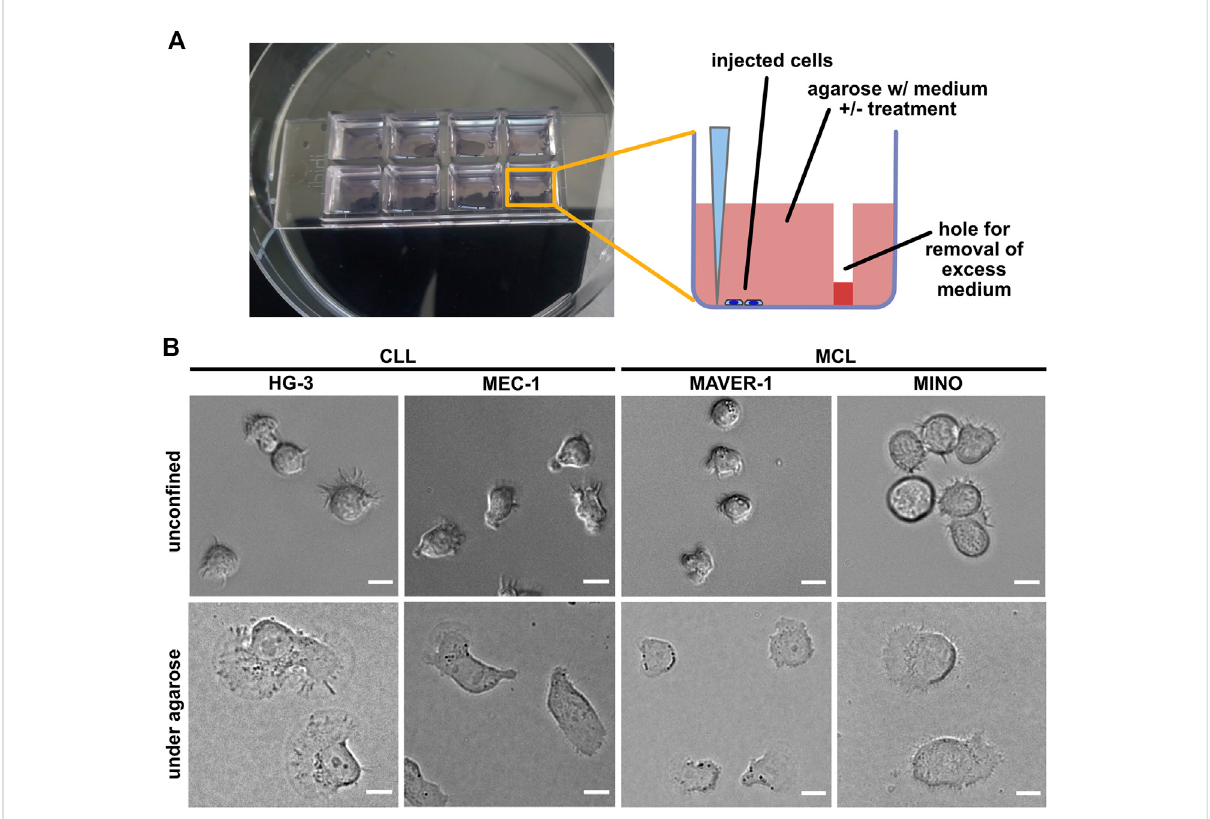
FIGURE 1 Experimentalsystemforanalysisofameboidmigrationofleukemiccelllines. (A) Schemeoftheunder-agaroseassayexperimentalsystemused for migration analysis. The cells are injected under the gel using a 10- μ l pipette at the side of the well opposite to hole punched in advance, which serves to collect excess medium. The collected medium needs to be removed before imaging to achieve ef fi cient con fi nement. Inhibitors or chemokines are added to the gelation mixture before the gel is poured into the wells. (B) Representative images of cell lines used in this study. Upper line: cell phenotypes in the normal 2D culture. Lower line: cell phenotypes in the under-agarose assay. Scale bar: 10 μ m. Representative videos of cell line behavior under con fi nement are located in Supplementary Movies S1 –